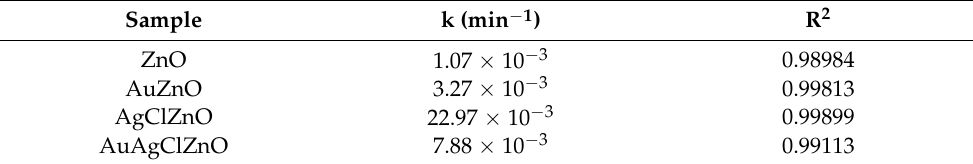
Figure 8. ( a ) ln(C 0 /C) vs. time for RhB degradation in the presence of the ZnO-based powders. The straight line represents the linear fit of the data; ( b ) ln(C 0 /C) vs. time for RhB degradation in the presence of the ZnO-based powders in dark conditions; ( c ) Time dependence of RhB degradation efficiency in the presence of ZnO-based powders. Table 1. The reaction rate constant k and the correlation coefficient R 2 .